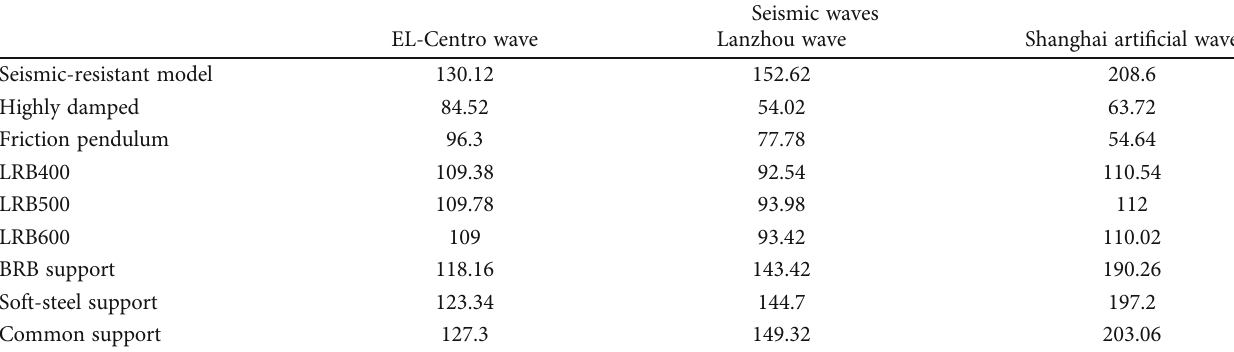
Table 3: Comparison of base shear force of each structure type under three seismic waves (unit: